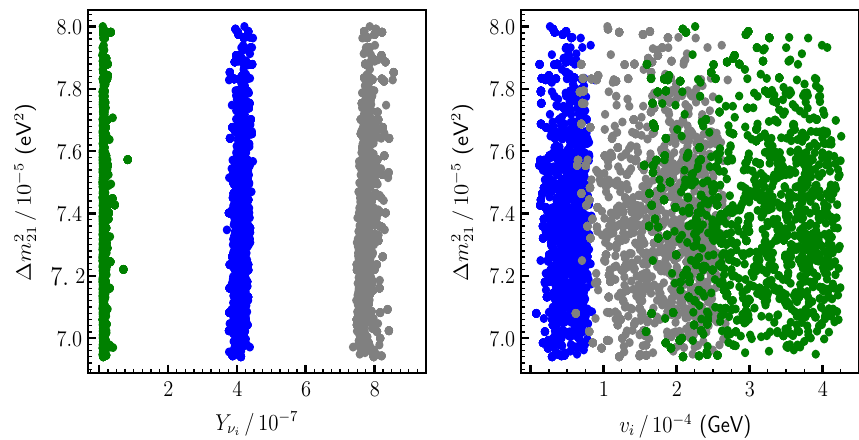
Fig. 1 (cid:4) m 2 versus neutrino 21 Yukawas (left) and LH sneutrino VEVs (right). Colors blue, green and grey correspond to i = 1 , 2 , 3,